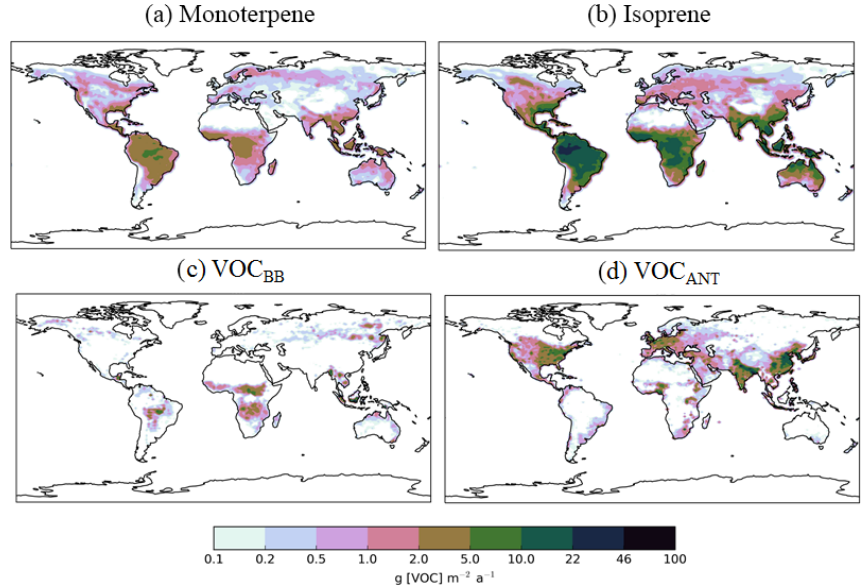
Figure 1. Annual-total SOA precursor emissions from the different global VOC sources; monoterpene and isoprene taken from Guenther et al. (1995), VOC BB taken from EDGAR, and VOC ANT taken from Lamarque et al. (2010). Units are g (VOC) m − 2 a − 1